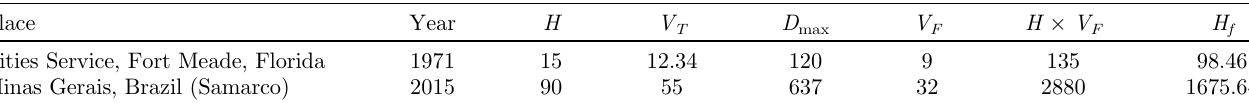
Table 8. Special cases.